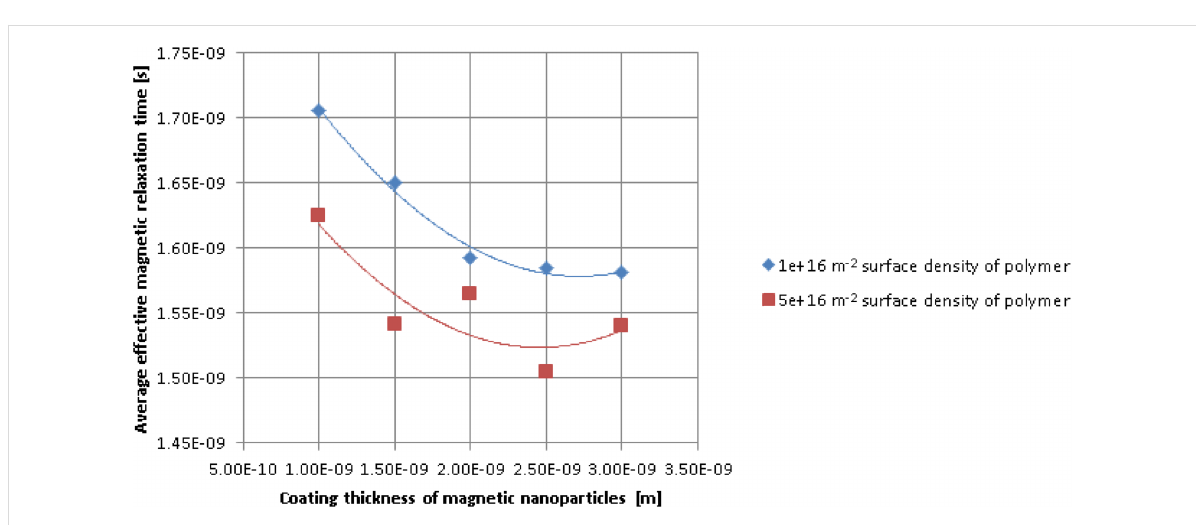
Figure 3: Average values of the effective magnetic relaxation time versus thickness of the nanoparticle coating layer, at low polymer surface density values.